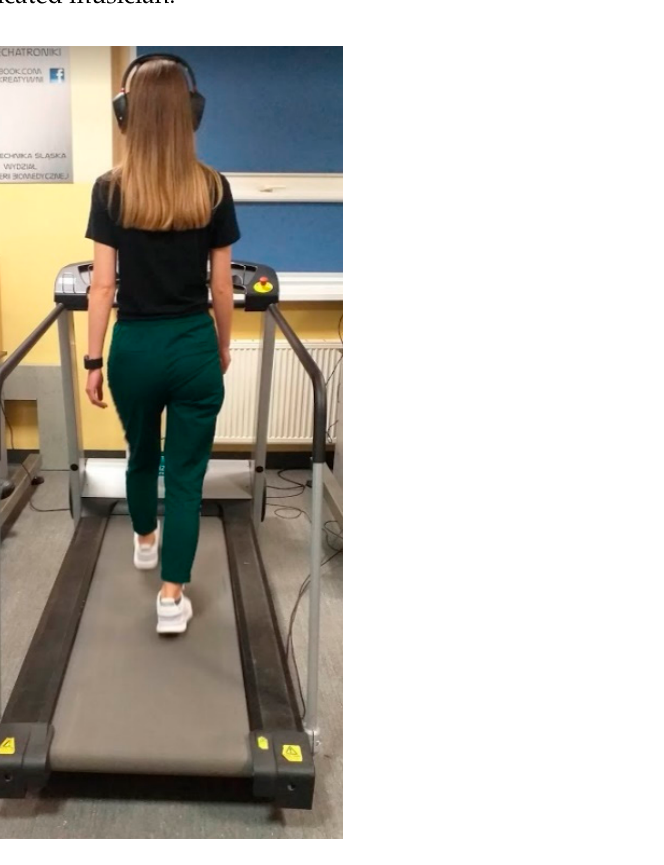
Figure 1. A participant during walking with the impact of acoustic stimuli.